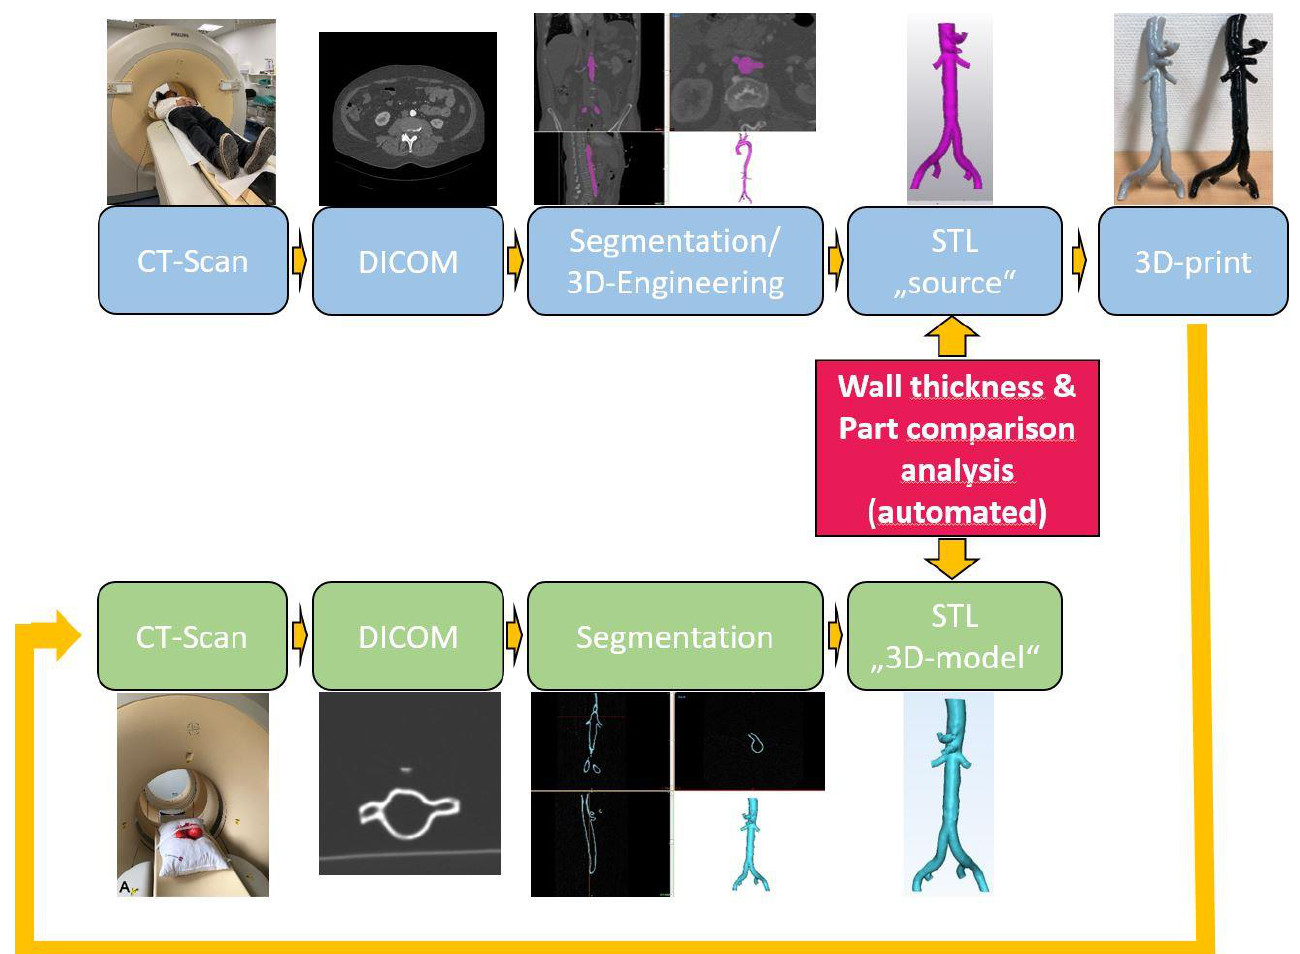
Figure 1. Schematic outline of study methodology: Standard workflow for in-house generation of 3D models is shown in the upper lane (light blue boxes). The specific workflow of this study is depicted in the lower lane (light green boxes). Here, the 3D-printed models were subjected to a high-resolution CT scan and an STL file was generated from the resulting DICOM dataset. Both STL files (source and 3D model) were then analyzed for wall thickness and three-dimensional part congruency using an automated software tool (Mimics Innovations Suite, Version 23, red box).